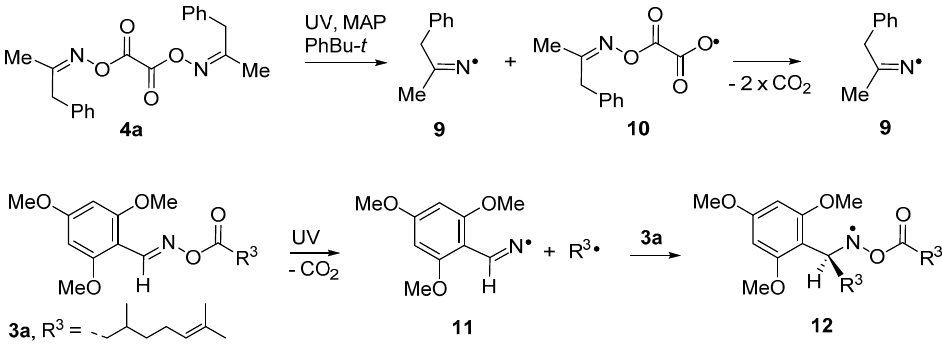
Scheme 2. Photolytic generation of iminyl radicals from carbonyl